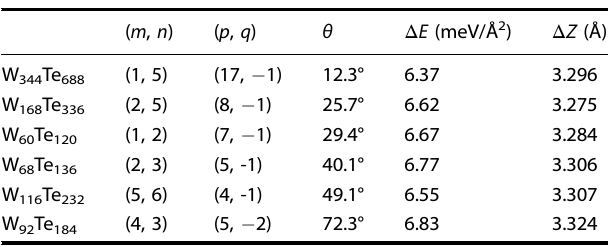
Table 1. Parameters of twisted bilayer WTe 2